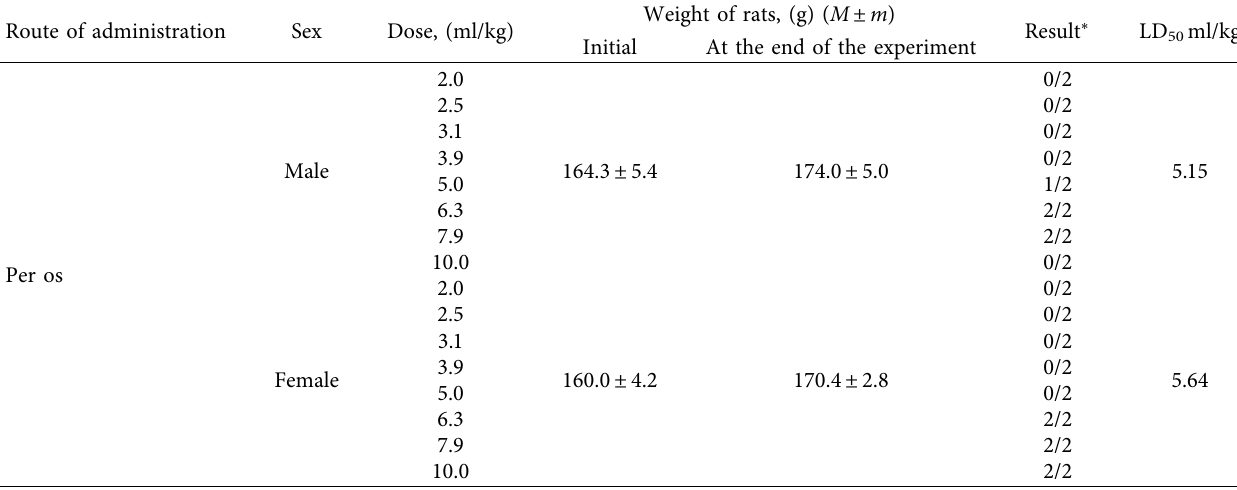
Table 3: Study of acute toxicity of CSLE.